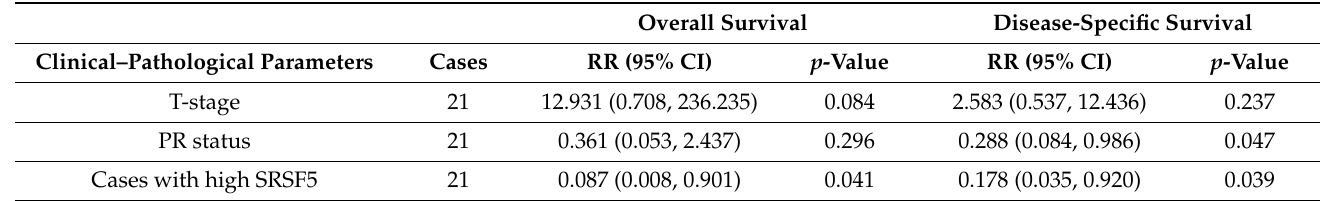
Table 4. Multivariate cox regression analysis of overall and disease-specific survival in ER +ve breast cancer. Overall